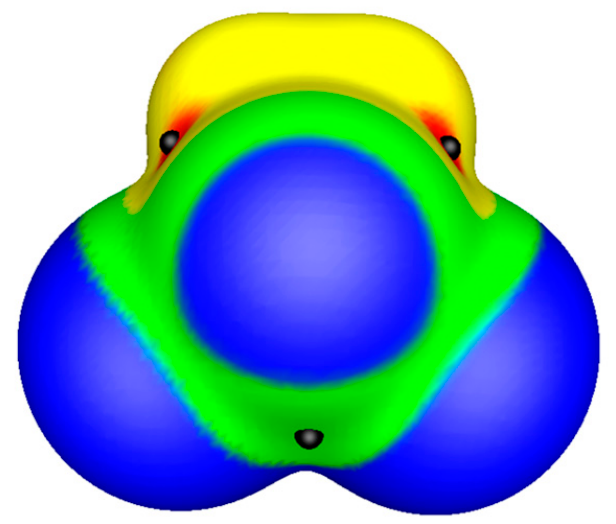
Figure 2. Computed electrostatic potential on 0.001 au molecular surface of P(CH 3 )Cl 2 . The phosphorus is in the center foreground, the chlorines are in the lower left and lower right. Black hemispheres indicate V S,max on the phosphorus, corresponding to the σ -holes due to the H 3 C–P and the two Cl–P bonds. Color ranges, in kcal/mol: red, more positive than 26; yellow, between 26 and 13; green, between 13 and 0; blue, negative.